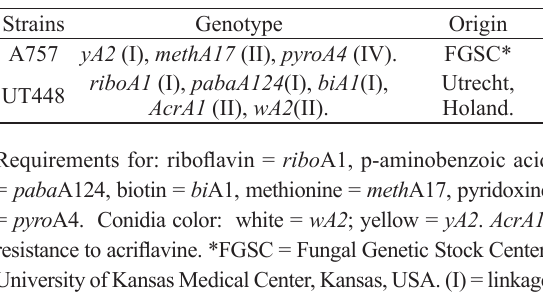
characterized as recombinogenic in human